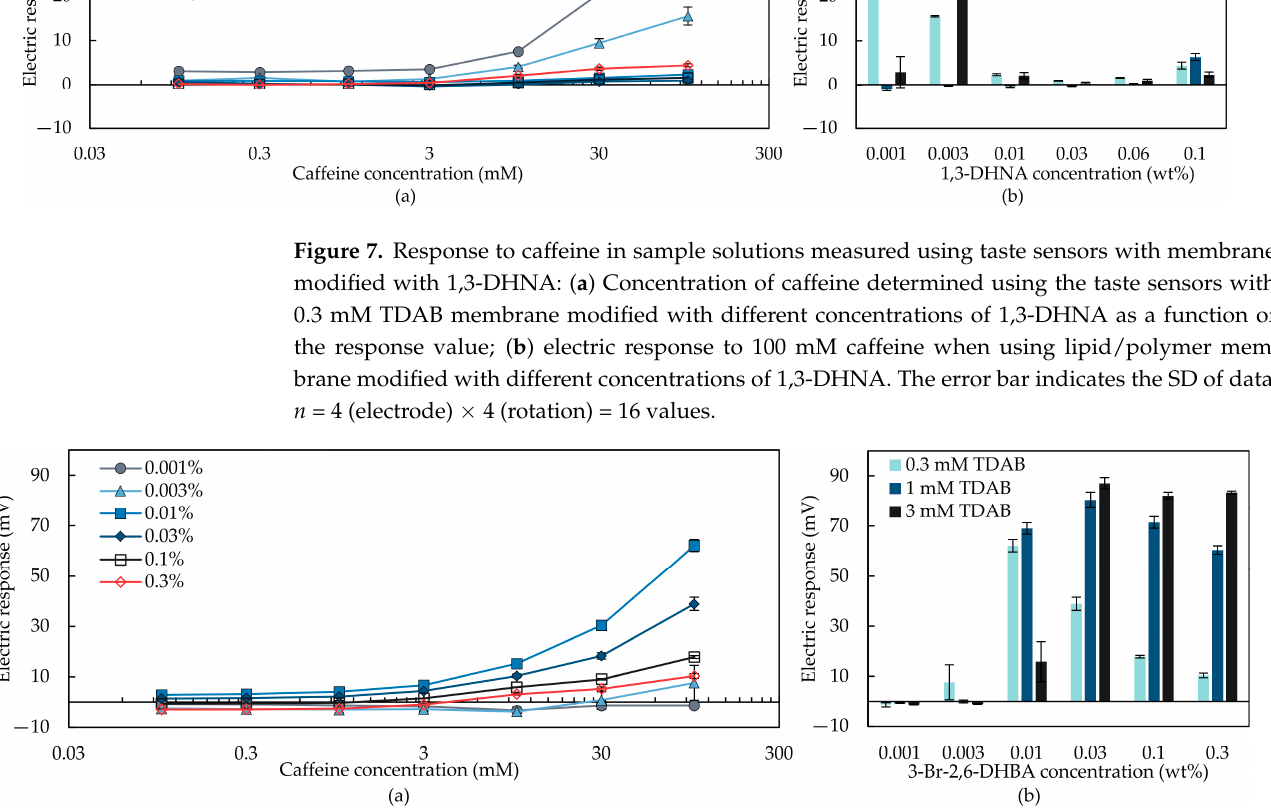
Figure 8. Response to caffeine in sample solutions measured using taste sensors with membrane modified with 3-Br-2,6-DHBA: ( a ) Concentration of caffeine determined using the taste sensors with 0.3 mM TDAB membrane modified with different concentrations of 3-Br-2,6-DHBA as a function of the response value; ( b ) electric response to 100 mM caffeine when using the lipid/polymer membrane modified with different concentrations of 3-Br-2,6-DHBA. The error bar indicates the SD of data, n = 4 (electrode) × 4 (rotation) = 16 values.